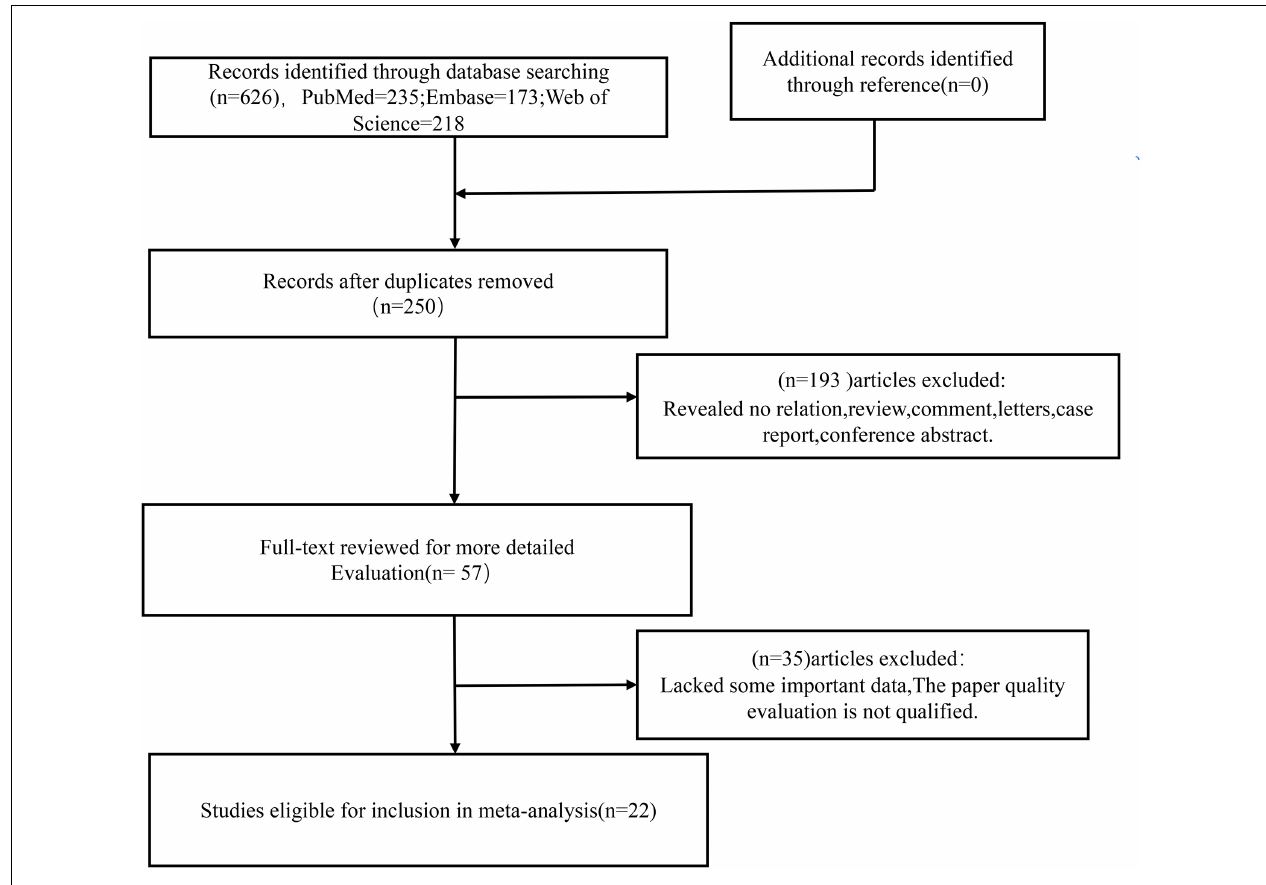
FIGURE 1 | Flow diagram of this